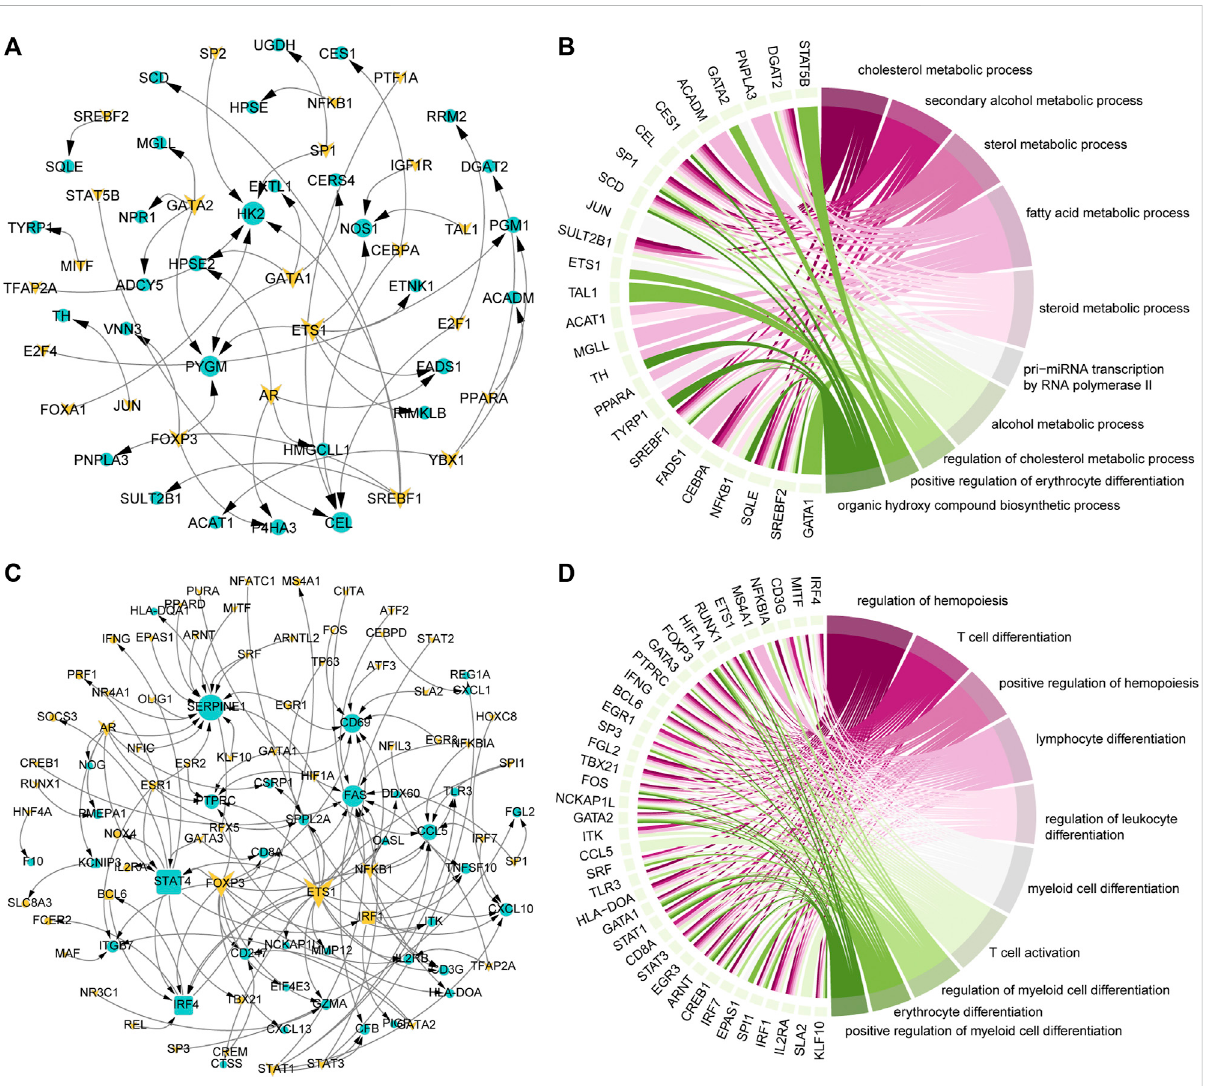
FIGURE 3 Key factors drive the reprogramming of metabolism and immunity. (A) Transcriptional regulatory network of metabolism-related genes that continue to be speci fi cally expressed in the development of COAD. The triangle represents TF, the circle represents the target gene. Genes that continue to be speci fi cally expressed in the development of COAD are marked in yellow. (B) The top 10 GO items enriched by genes in the (A) network. The interaction between genes and the GO items is shown. (C) Same as in (A) but for immune-related genes that continue to be speci fi cally expressed in the development of COAD. (D) Same as in (B) but for genes in the (C)